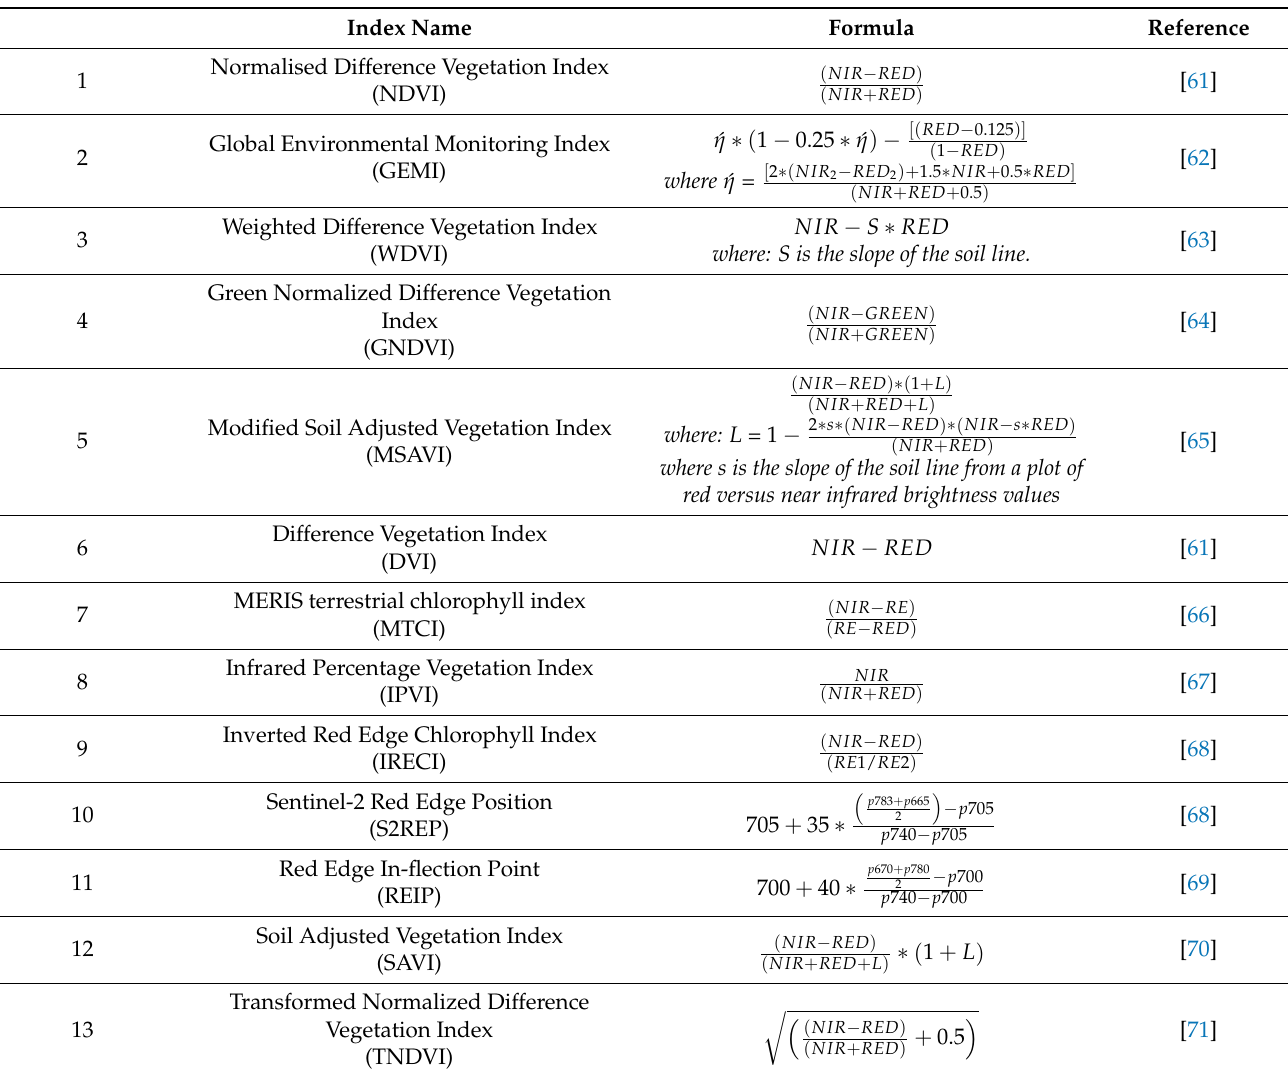
Table A1. Vegetation indices used in the present